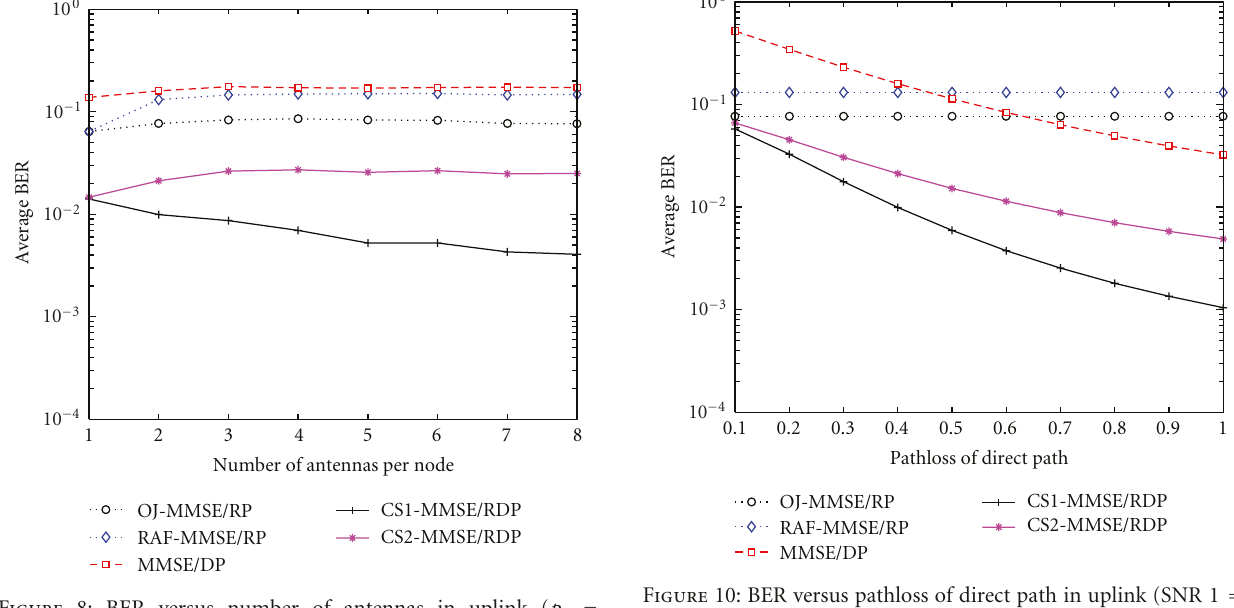
Figure 8: BER versus number of antennas in uplink ( p = 0 . 4, SNR1 = SNR2 = 15dB) .